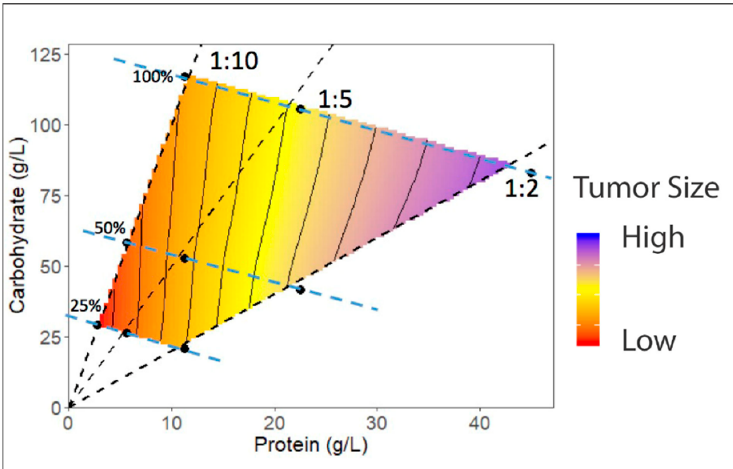
Figure 2. Graphical representation of Nutritional Geometry. A hypothetical interaction between protein (P) and carbohydrate (C) content within the larval diet on tumor size. Larvae fed a diet of both high protein and sugars are predicted to display the greatest levels of tumor growth. The response surface (represented by the colour gradient and thin black contours), generated using thin plate splines, is generated by fitting to tumor size across the nine different diets (filled black circles). These diets consist of one of three P:C ratios (dashed black lines; P:C = 1:2, 1:5, or 1:10) at one of three caloric densities (25%, 50%, and 100%; represented by blue dashed lines). In this case, tumor size is maximised by diets with a high P:C ratio and low caloric density. Tumor size increases as dietary protein increases, with no effect of dietary carbohydrates.